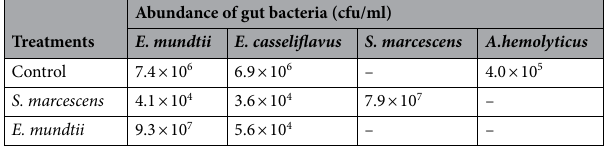
Table 3. Effect of oral ingestion of S. marcescens and E. mundtii on gut microbial diversity of S. litura larvae.